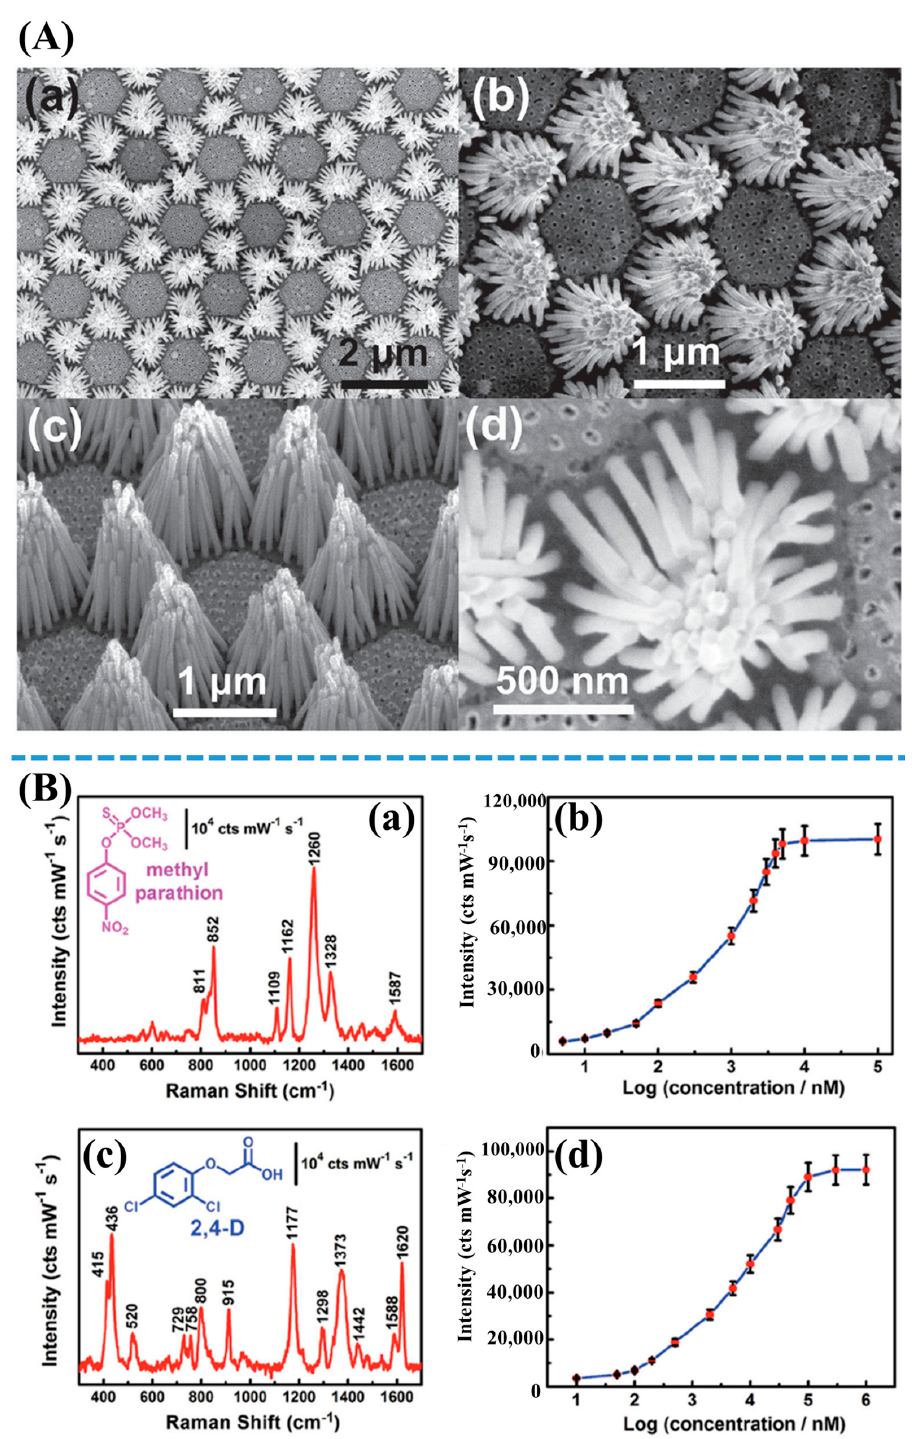
Figure 7. ( A ) SEM images of vertical bundles of Ag nanorods including top views with different scale bars of (a) 1 μ m and (b) 2 μ m, ( c ) side view of vertical bundle arrays of Ag nanorods, and (d) top view of one unique bundle of Ag-nanorods. ( B ) Vertical bundle arrays of Ag nanorod-based Raman detection of phenolic pollutants of (a) methyl parathion (0.3 × 10 − 6 M). (b) Linear curve of logarithmic concentration of methyl parathion-correlated Raman intensities (1260 cm − 1 ). (c) Raman spectra of 2,4-D (2 × 10 − 6 M). (d) Linear curve of logarithmic concentration of 2,4-D-correclated Raman intensities (1177 cm –1 ). Adapted from [103].